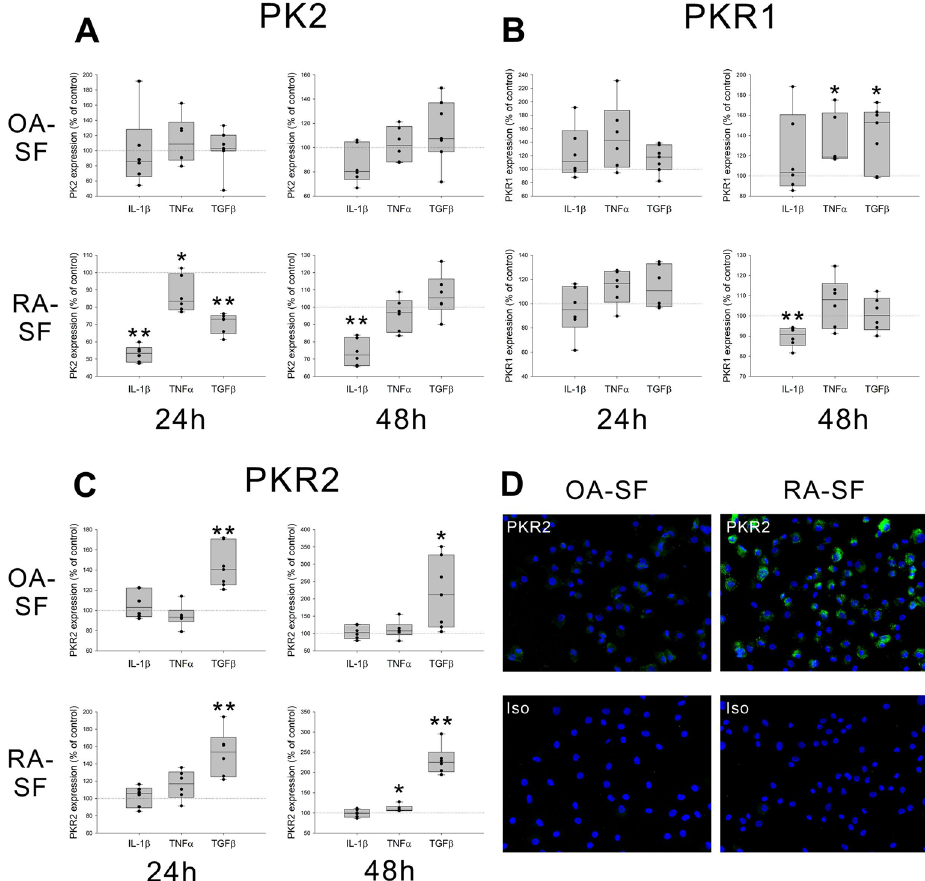
Figure 4. Modulation of PK2, PKR1, and PKR2 expression in OA- and RA-SF under proinflammatory conditions. PK2 ( A ), PKR1 ( B ), and PKR2 ( C ) proteins in OA- and RA-SF were examined by cell-based ELISAs at 24 and 48 h after stimulation with IL-1β (200 pg/ml), TNFα (10 ng/ml), and TGFβ (10 ng/ml). ( D ) Immunofluorescent staining of PKR2 in OA- and RA-SF at 48 h after stimulation with TGFβ. N = 6–7. Green staining indicates PKR2-positive cells (× 200). Staining with an isotype control as the primary antibody is also given. Data are shown as box plots, the description of which is given in the legend to Fig. 2. Each dot in the figure represents a different cell line derived from a different patient. For statistical analysis, the one-sample Wilcoxon signed-rank test (when data did not follow a normal distribution) or the one-sample t-test was used (when data were normally distributed). *p < 0.05, **p < 0.01. PK2 prokineticin 2, PKR1 prokineticin receptor 1, PKR2 prokineticin receptor 2, OA osteoarthritis, RA rheumatoid arthritis, SF synovial fibroblasts,